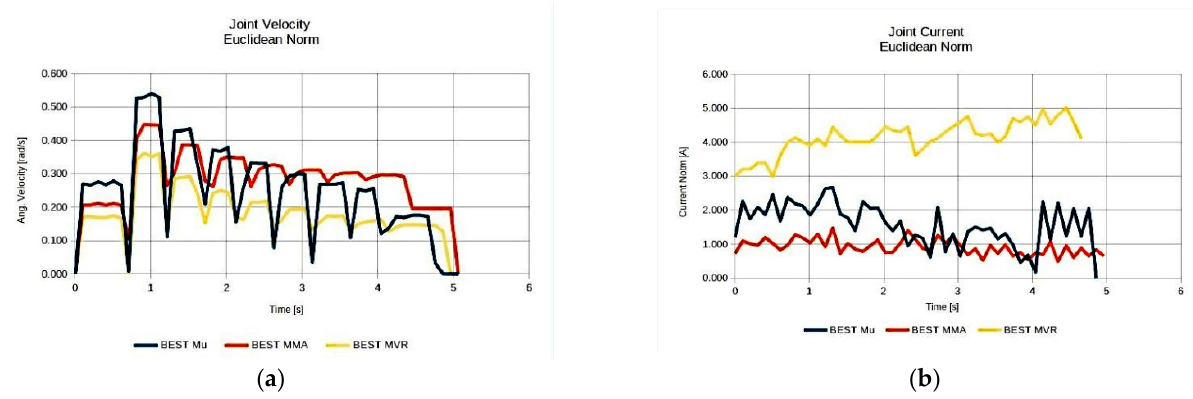
Figure 8. Comparison of the required joint velocities ( a ) and joint current usage ( b ) for the best anatomies under each performance index for Task 1.